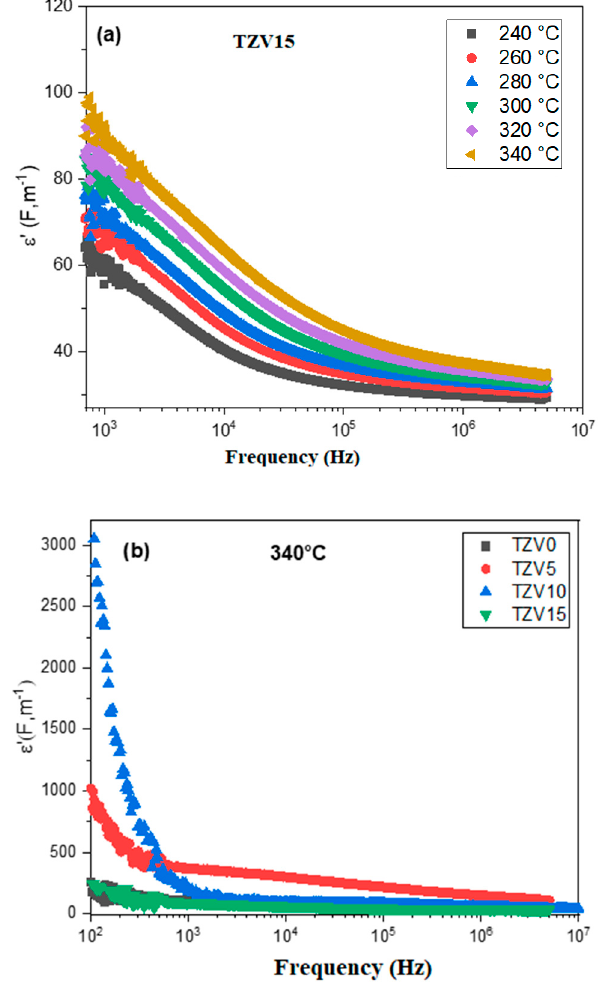
Figure 11. Frequency dependence of dielectric constant of ( a ) TZV15 glass sample at different temperatures and ( b ) different glass samples at T = 340 °C.